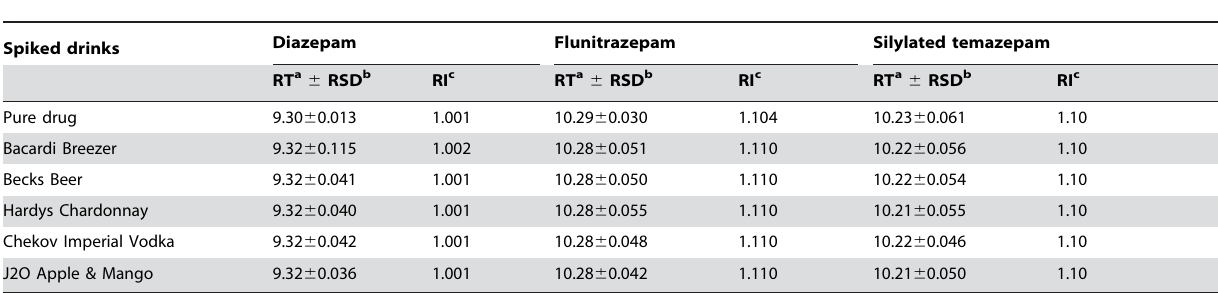
Table 1. Compound identification parameters